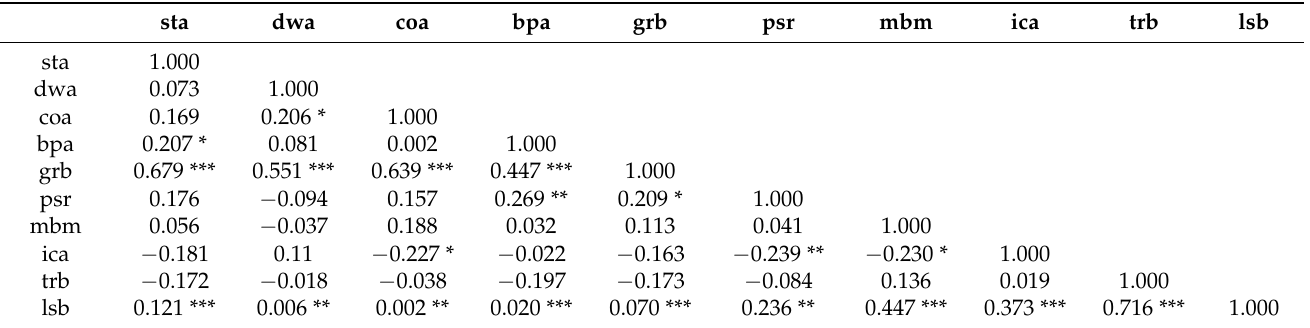
Table 9. The correlation matrix of hidden variables of the